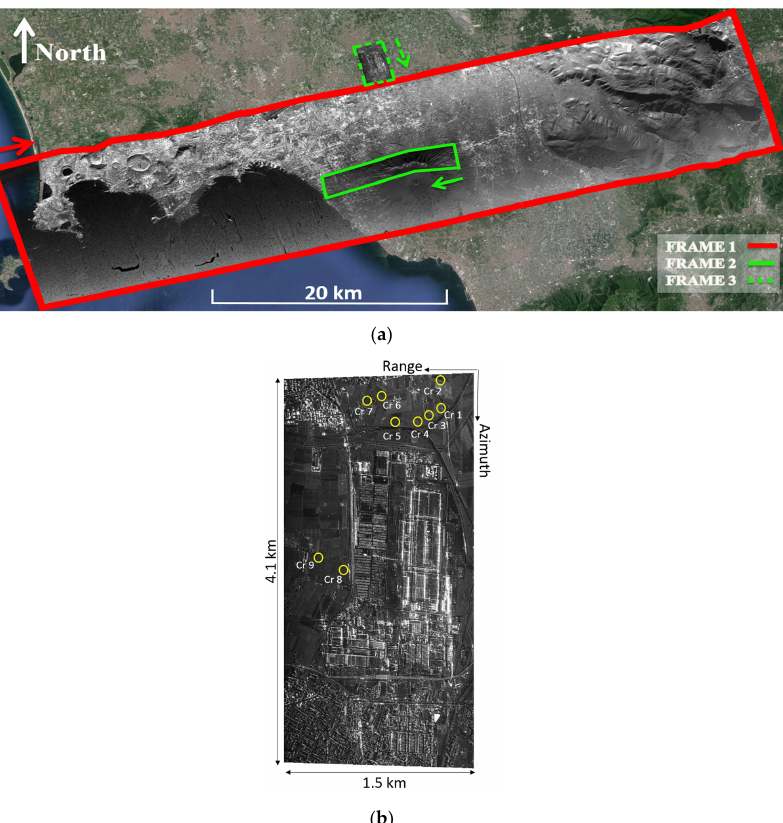
Figure 3. ( a ) Multi-look amplitude SAR images relevant to the acquired data. The frame n.1 (red) is relevant to the 50 MHz mode; the frame n.2 (continuous green) and the frame n.3 (dashed green) are relevant to the 400 MHz mode. The images are geocoded on a 5 × 5 m (50 MHz mode) and 1 × 1 m (400 MHz mode) geographic grid, and superimposed on a Google Earth image. The green and red arrows indicate the flight directions; ( b ) Amplitude SAR image (in the SAR coordinates grid) relevant to the frame n.3. A 4 range × 16 azimuth pixel averaging window has been applied, obtaining a 1.5 m × 1.85 m pixel spacing. The CRs deployed over the area are highlighted with yellow circles.